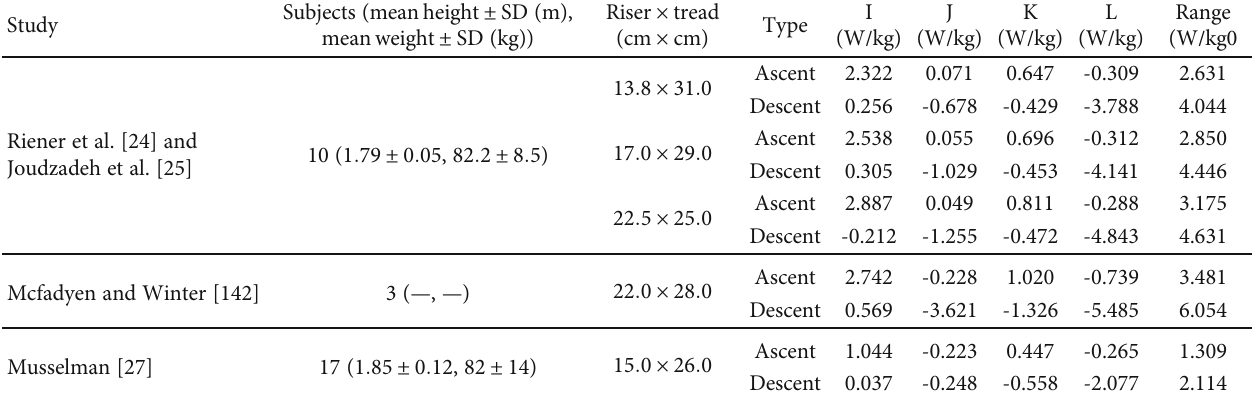
Table 9: Overview over the experimental results of knee power for stair ascent and stair descent. Study